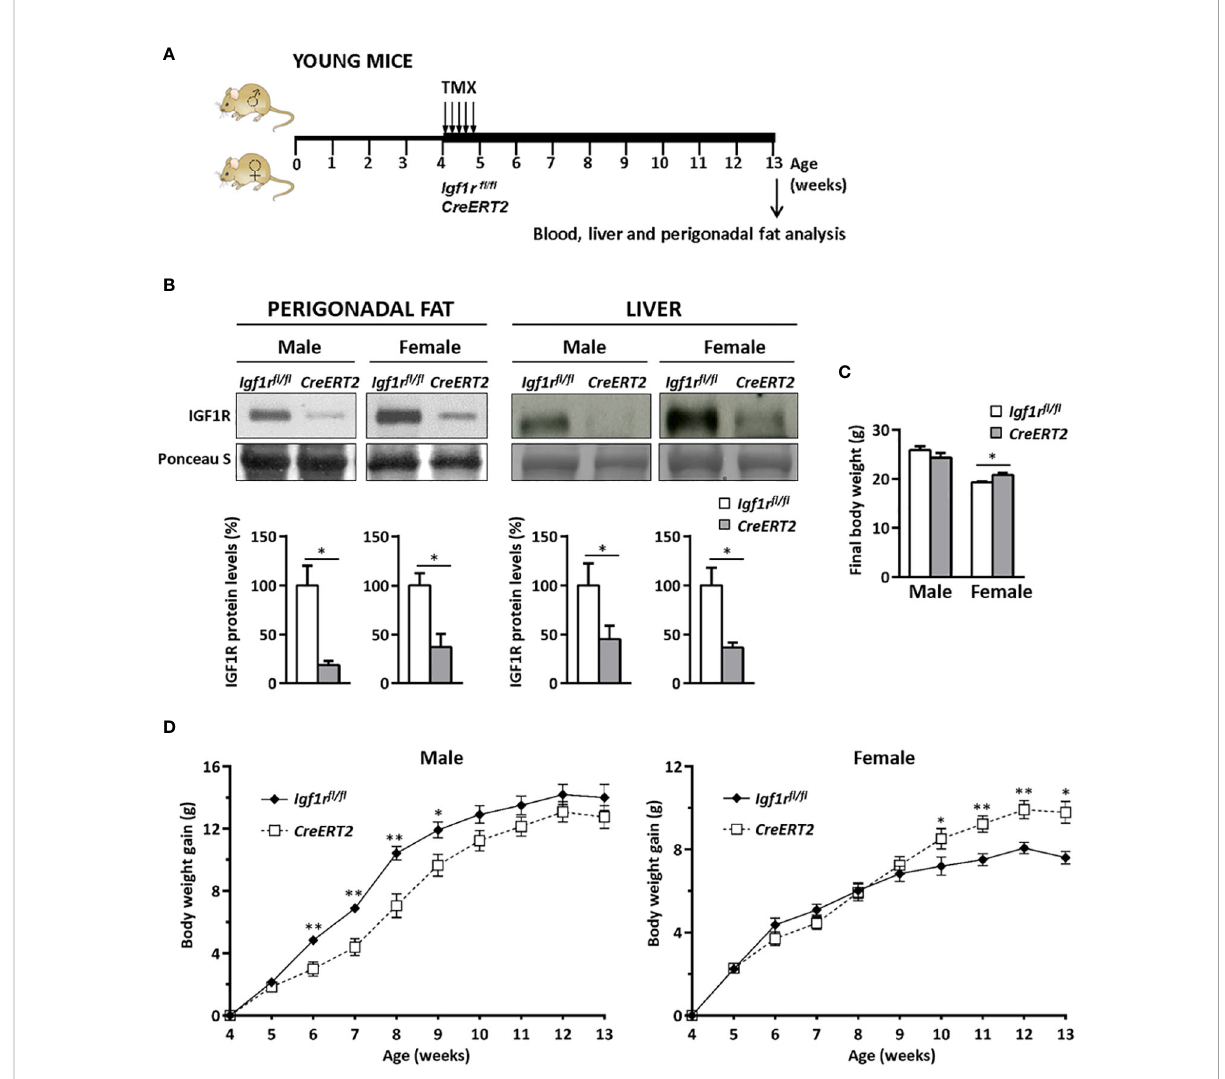
FIGURE 1 Experimental design to study the metabolic effects of IGF1R de fi ciency on CreERT2 young mice, IGF1R protein levels in perigonadal fat and liver and changes in body weight gain. (A) Tamoxifen (TMX) was administered daily for 5 consecutive days to Igf1r fl / fl and UBC-CreERT2; Igf1r fl / fl four-weeks-old animals to generate control Igf1r fl / fl and IGF1R-de fi cient CreERT2 mice. Body weight was measured weekly up to their sacri fi ce on week 13 for sample collection, and molecular and histological analyses. (B) Representative Western blots for IGF1R protein levels and graphical representation of densitometric measurements of band intensities normalized to Ponceau S staining and expressed as percentage in 13 weeks-old male ( Igf1r fl / fl , n = 3; CreERT2 , n = 3) and female ( Igf1r fl / fl , n = 2; CreERT2 , n = 3) in perigonadal fat (left) and also in liver from 13 weeks-old male ( Igf1r fl / fl , n = 5; CreERT2 , n = 5) and female ( Igf1r fl / fl , n = 5; CreERT2 , n = 4) (right). (C) Body weight of male ( Igf1r fl / fl , n = 11; CreERT2 , n = 14) and female ( Igf1r fl / fl , n = 9, CreERT2 , n = 10) mice at the age of 13 weeks. (D) Body weight gain curves of male ( Igf1r fl / fl , n = 11; CreERT2 , n = 14) and female ( Igf1r fl / fl , n = 8; CreERT2 , n = 9) mice representing the weekly mean of body weight gain on each genotype. Data are expressed as mean ± SEM. *p < 0.05, **p < 0.01 vs. Igf1r fl / fl corresponding